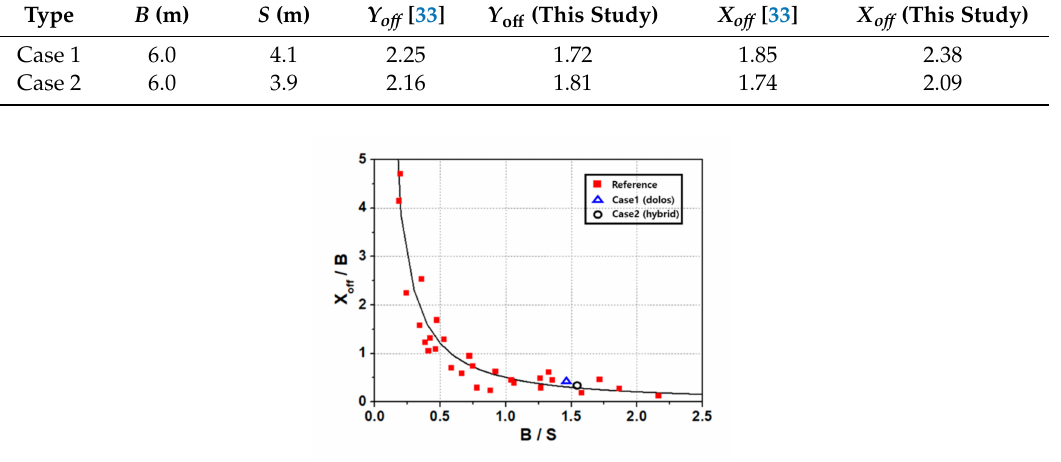
Figure 11. Comparison between the present study (Case 1 and Case 2) and the reference data (Black and Andrews,